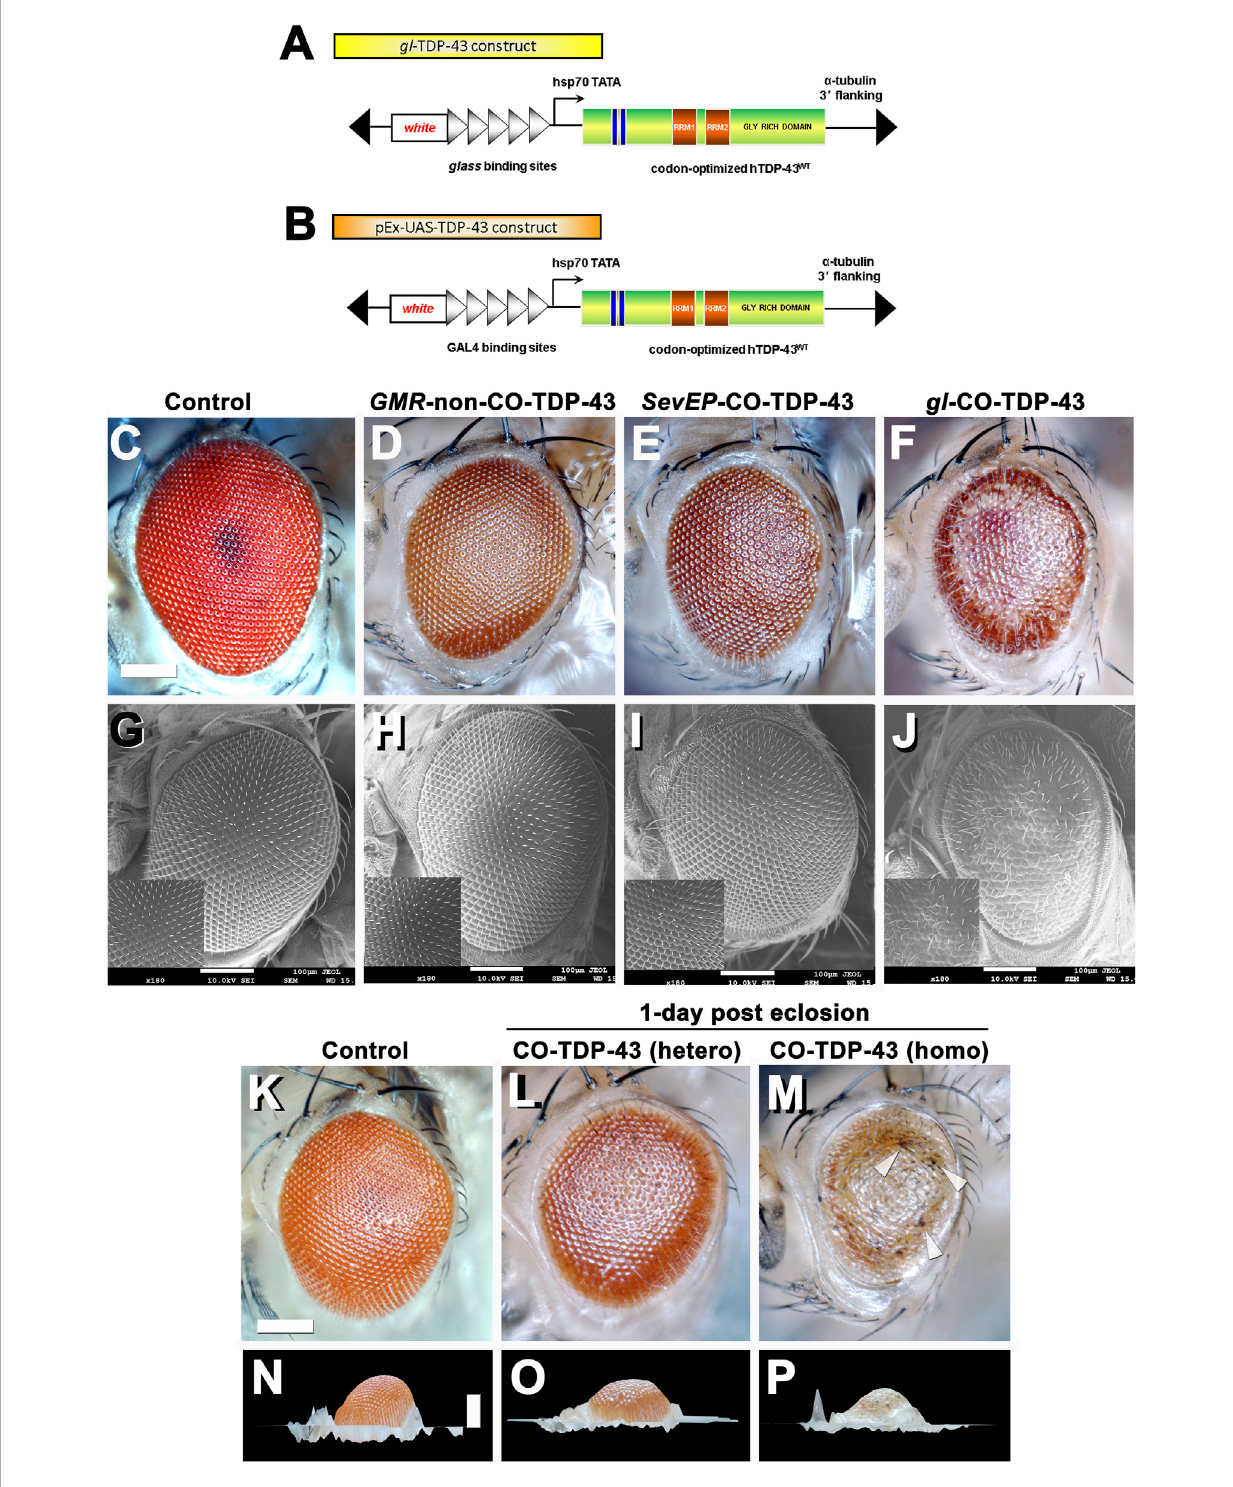
FIGURE 1 Misexpression of codon optimized TDP-43 induces depigmentation and irregularities in bristles compared to existing human wild-type TDP-43 lines. Transgenic fl ies stably express wild-type or codon optimized TDP-43 using eye promoters. All stocks were kept and maintained at room temperature (22 ° C). (A, B) Schematic of the CO-TDP-43 constructs using glass direct fusion promoter vector and UAS vector used to create the transgenic CO-TDP-43 lines. (C – J) Photomicrograph and scanning electron microscopy (SEM) images of the adult retina at 10-days post-eclosion (scalebar100 uM).Compared toexisting humanwild-type non-CO-TDP-43transgenic fl iesexpressed using GMR -GAL4promoter (D,H) ,theCO-TDP- 43 fl iesusing gl ass directfusionpromoter (F, J) exhibitarobusteye phenotype including depigmentation,disruption inplanarpolarity and loss ofbristles. SevEP -GAL4, a selective R7 and R8 photoreceptor neuron driver, recombined with CO-TDP-43 (E, I) also shows the same phenotypes. (C, G) are controls. (K – P) The robust phenotype mediated by CO-TDP-43 is both age and dosage dependent. At 1-day post-eclosion, CO-TDP-43 (L) shows